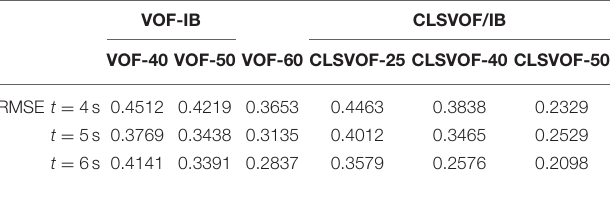
TABLE 1 | Numerical error estimation.